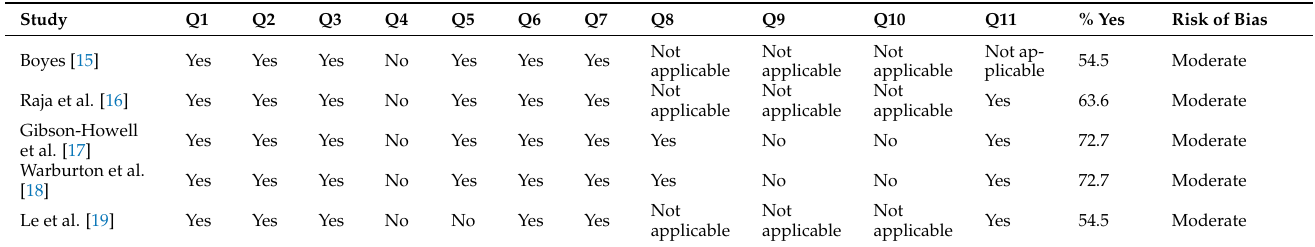
Table 4. Risk of bias assessment for cohort studies according to the JBI tool (sorted in order of year of publication) [33].